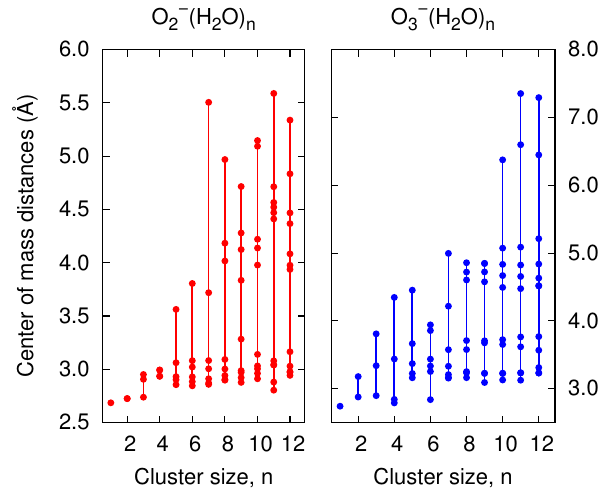
Fig. 5. Plots of center-of-mass, radial distribution functions, as function of n . In both clusters, at least two hydration shells are apparent. A complete first hydration shell contains 5 H 2 O. Note the difference in scales indicating smaller and hence more stable ( H 2 O ) n than corresponding O − ( H 2 O ) n O − 2 3